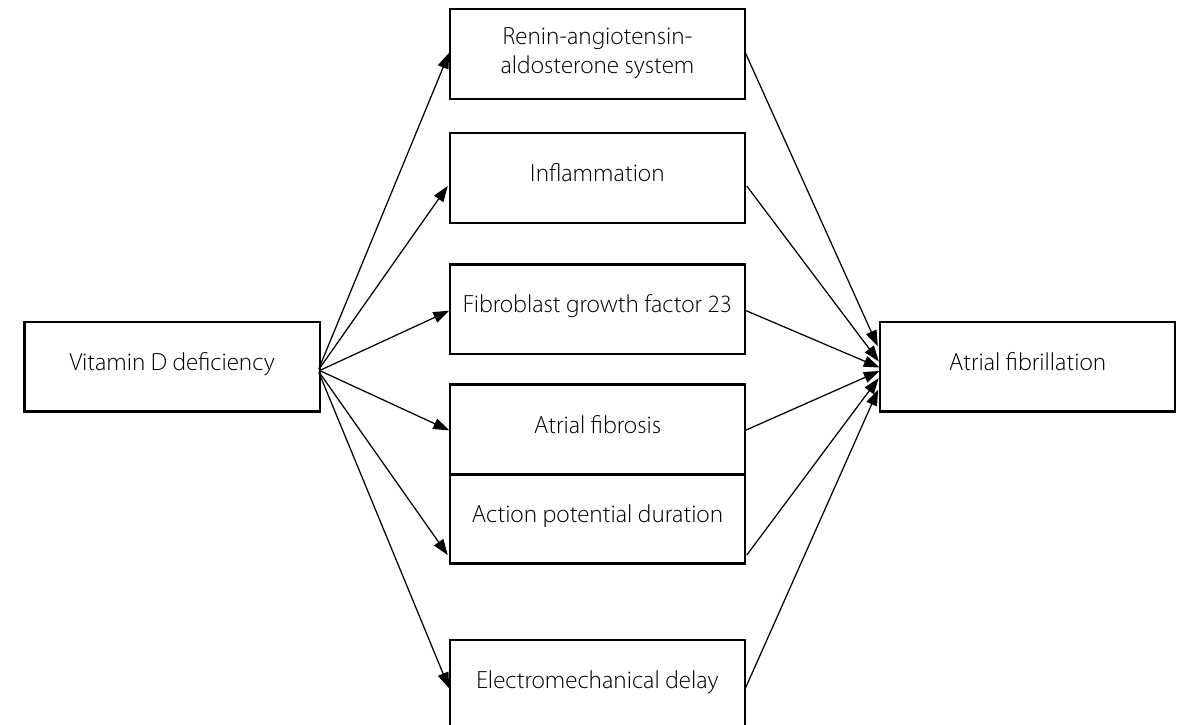
Fig. 1 – Mechanism of vitamin D deficiency leading to atrial